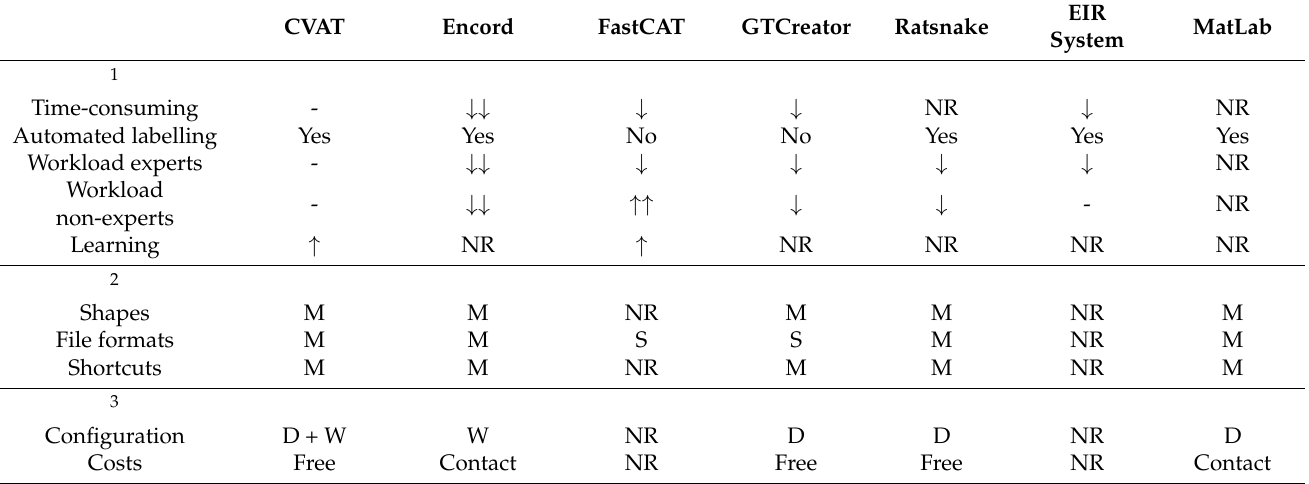
Table 1. Synthesized information from the annotation tools in question. The different